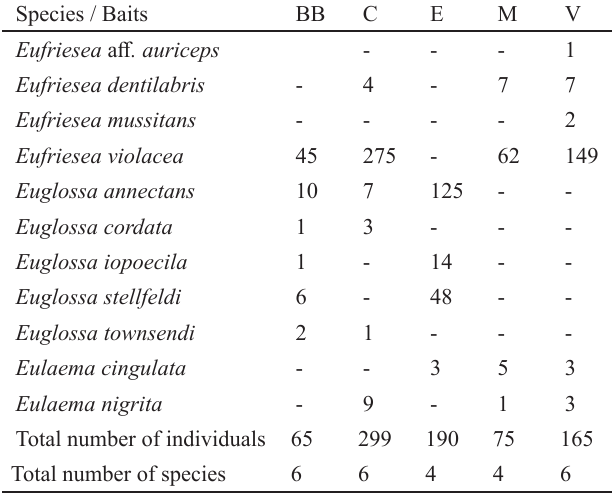
Table 3 . Number of males for each species, baited by different odor baits in the periods between September/2013 and April/2015, in the northern region of Santa Catarina. Subtitles: BB- Benzyl